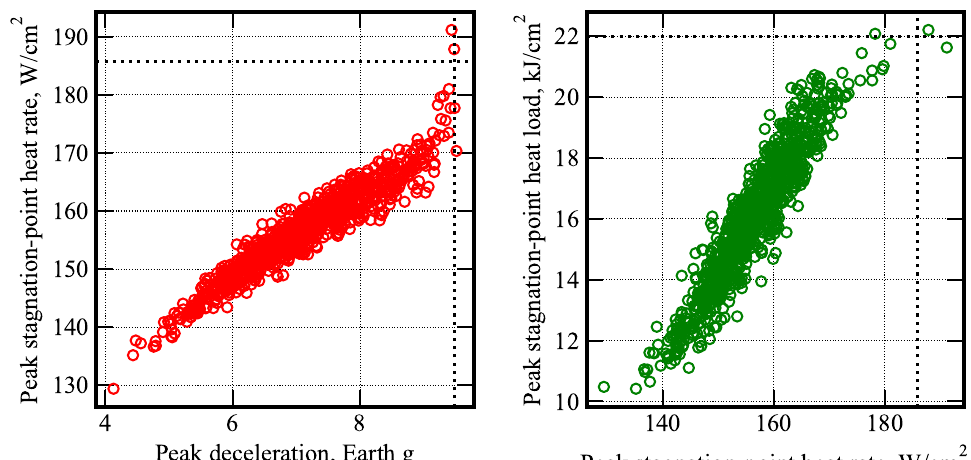
Figure 22. Scatter plots of the peak deceleration, peak stagnation-point heat rate and the total heat load for Venus aerocapture. The black dotted line indicates the 99.87 percentile